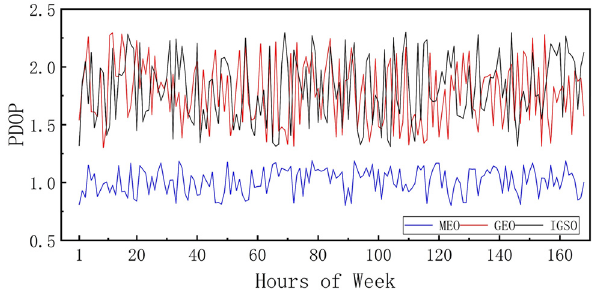
Figure 6: PDOP of the MEO, GEO, and IGSO in a single week.